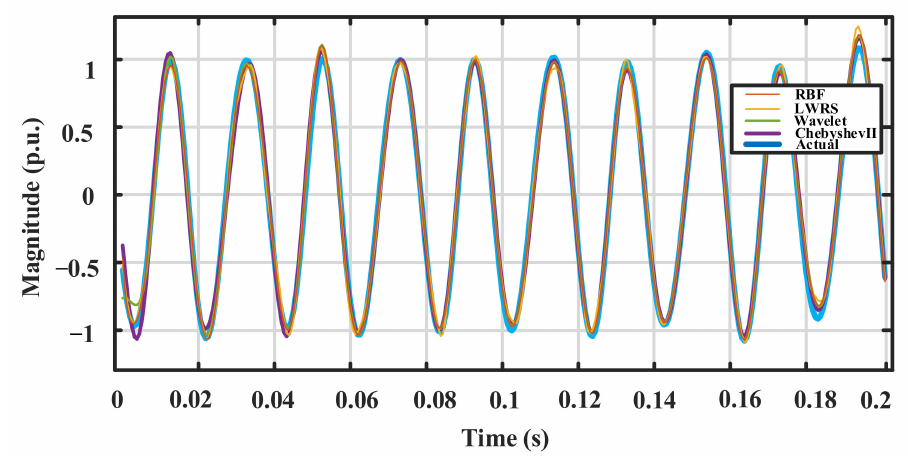
Figure 10. Comparison of fitting results.